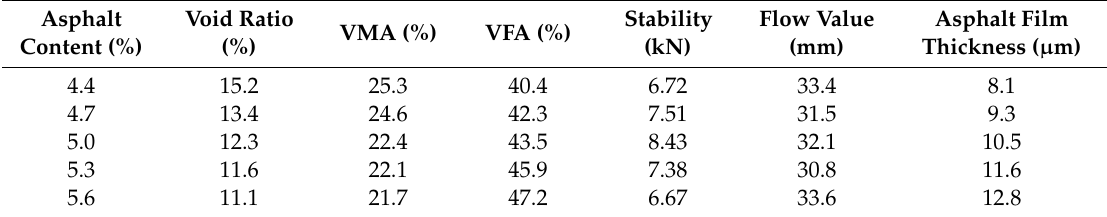
Table A3. The volume parameters of Novachip-B.